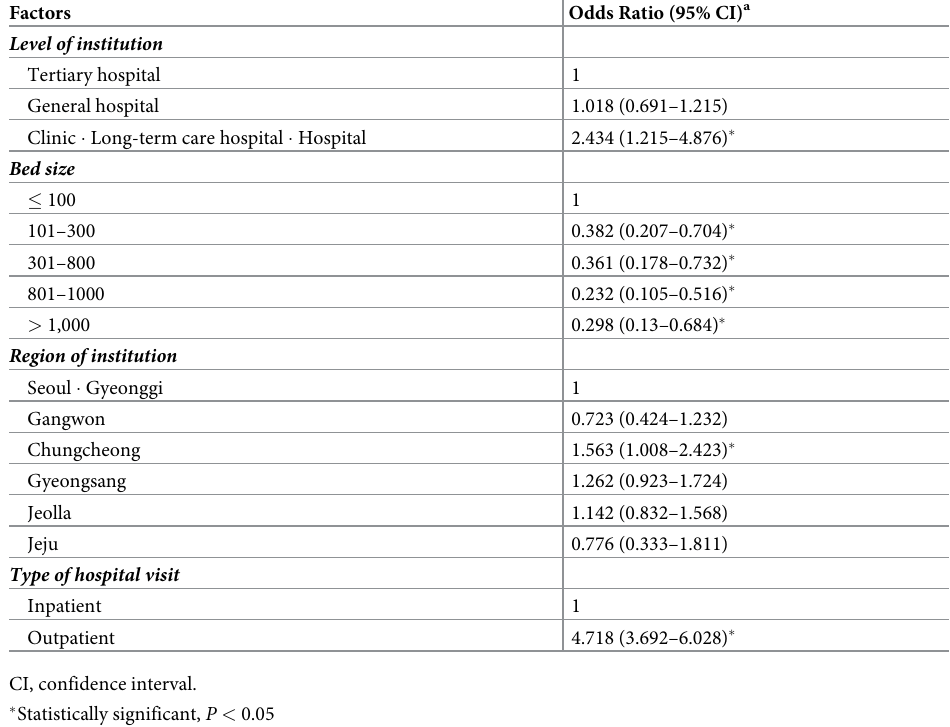
Table 3. Factors associated with concomitant use of contraindicated drugs in patients with atrial fibrillation aged over 65 who received direct oral anticoagulants.